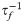
Overview of KPR-based immune recognition circuits.Receptors can form complexes with foreign ligands C and self ligands D. These complexes disassociate at different rates given by τf-1 and τs-1, respectively. Once a receptor-ligand complex is formed, it is phosphorylated at a rate ϕ and dephosphorylated as a rate b. Importantly, ligands can directly form a complex at the n-th step of the KPR cascade at a rate γn/τi(i = s, f). In adaptive sorting circuit, the phosphorlyation/dephosphorylation rates can be modulated by a kinase-dependent feedback loop (see main text). A full definition of symbols can be found at Table 1.